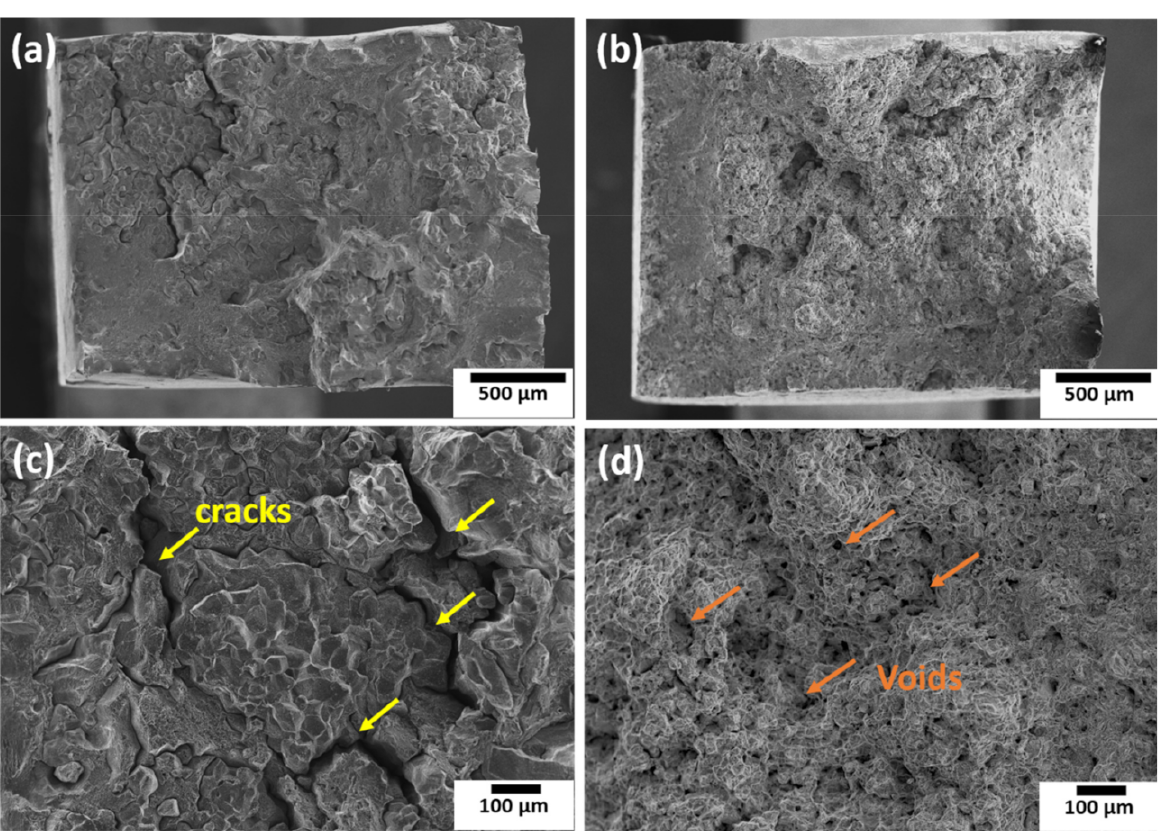
Figure 13. SEM micrographs showing fracture surface morphologies of specimens after the creep test for ( a , c ) the EBM IN718 STA specimen and ( b , d ) the C&W IN718